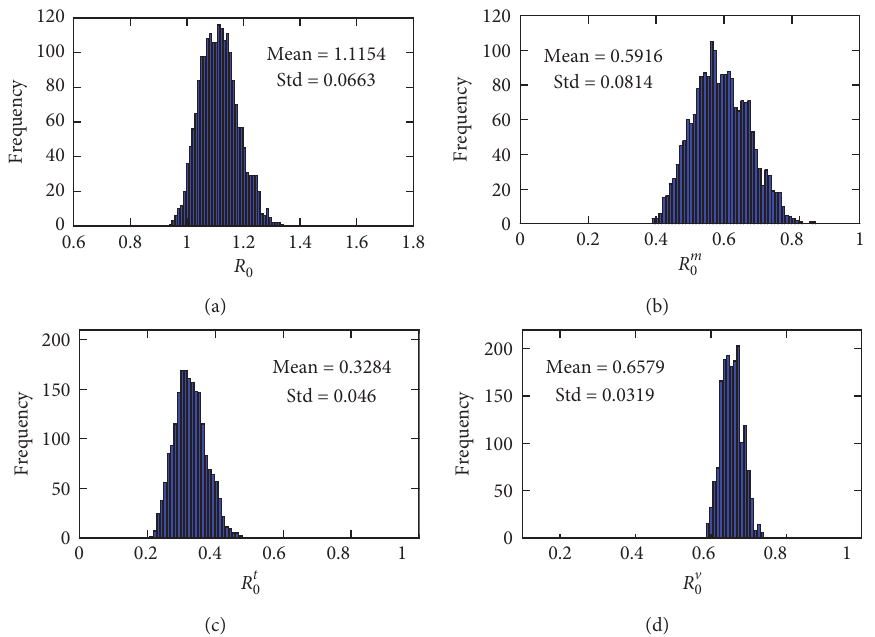
Figure 4: Uncertainty analysis of reproduction number R simulations with varied parameters. (a) Baseline case. (b) Medication. (c) Test-and-cull. (d) Vaccination.